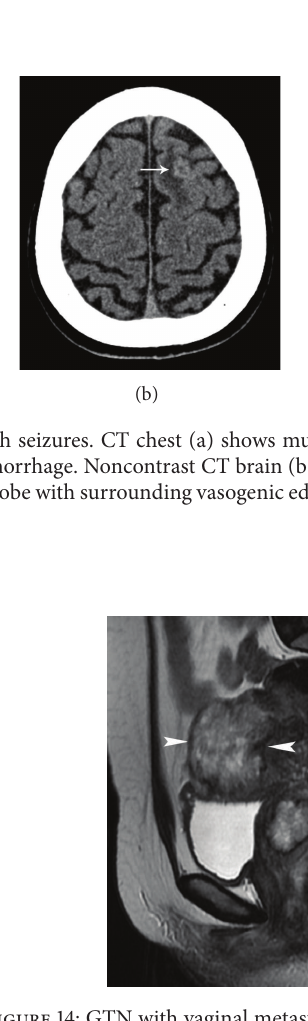
Figure 14: GTN with vaginal metastases. Sagittal T2-weighted MR image shows a lobulated heterogeneously hyperintense myometrial mass with ill-defined margins (arrowheads) and effacement of nor- mal zonal anatomy of uterus. Two morphologically similar lesions (arrows) are seen in the vaginal wall consistent with metastases, which were missed on initial